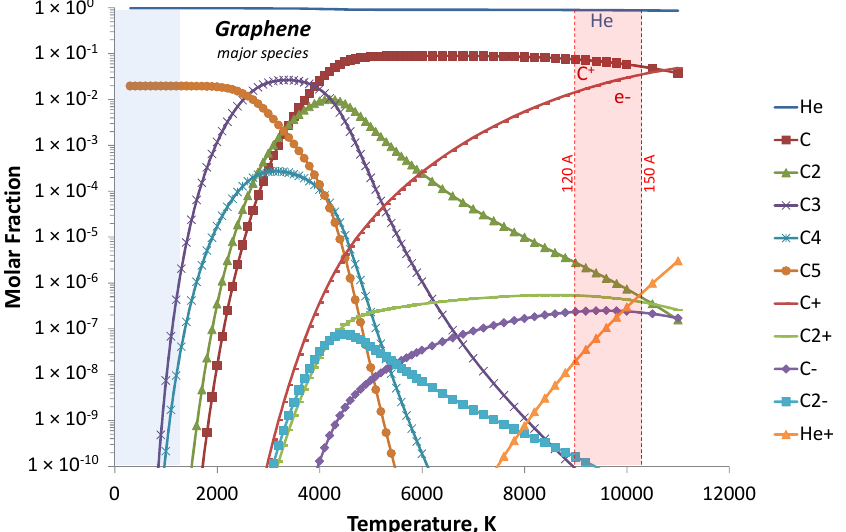
Figure 14. Calculated equilibrium species in the interelectrode gap (red zone) and cold cathode (blue zone) at a total pressure of 530 mbar.